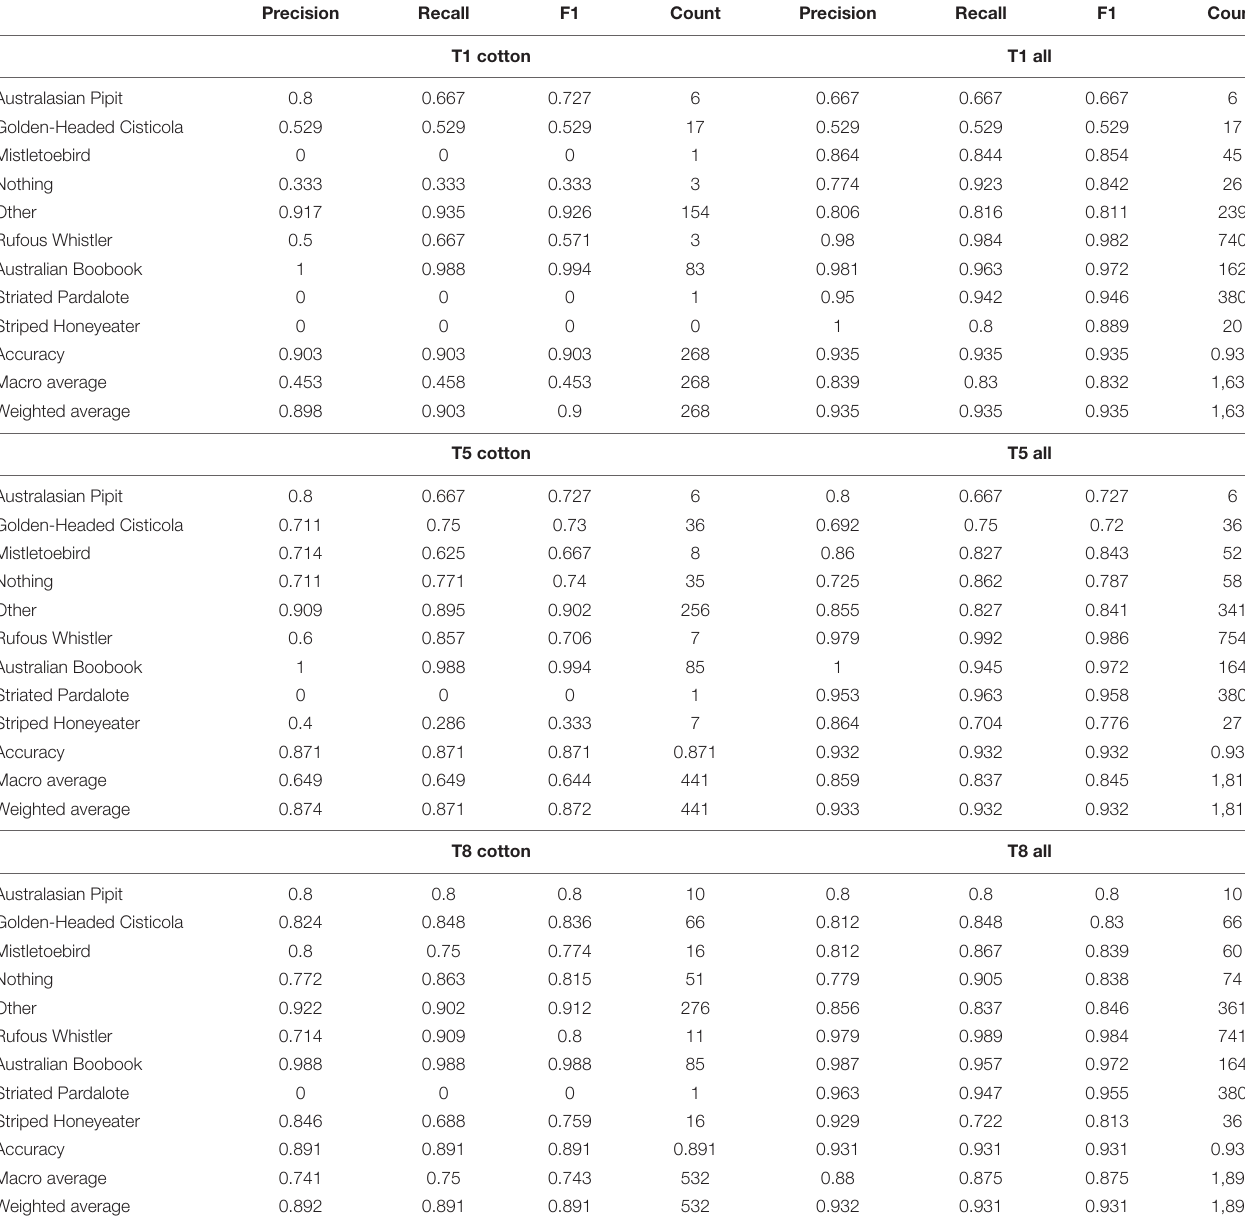
TABLE 4 | Metrics for classification on test set for i teration 1, 5, and 8. Precision Recall F1 Count Precision Recall